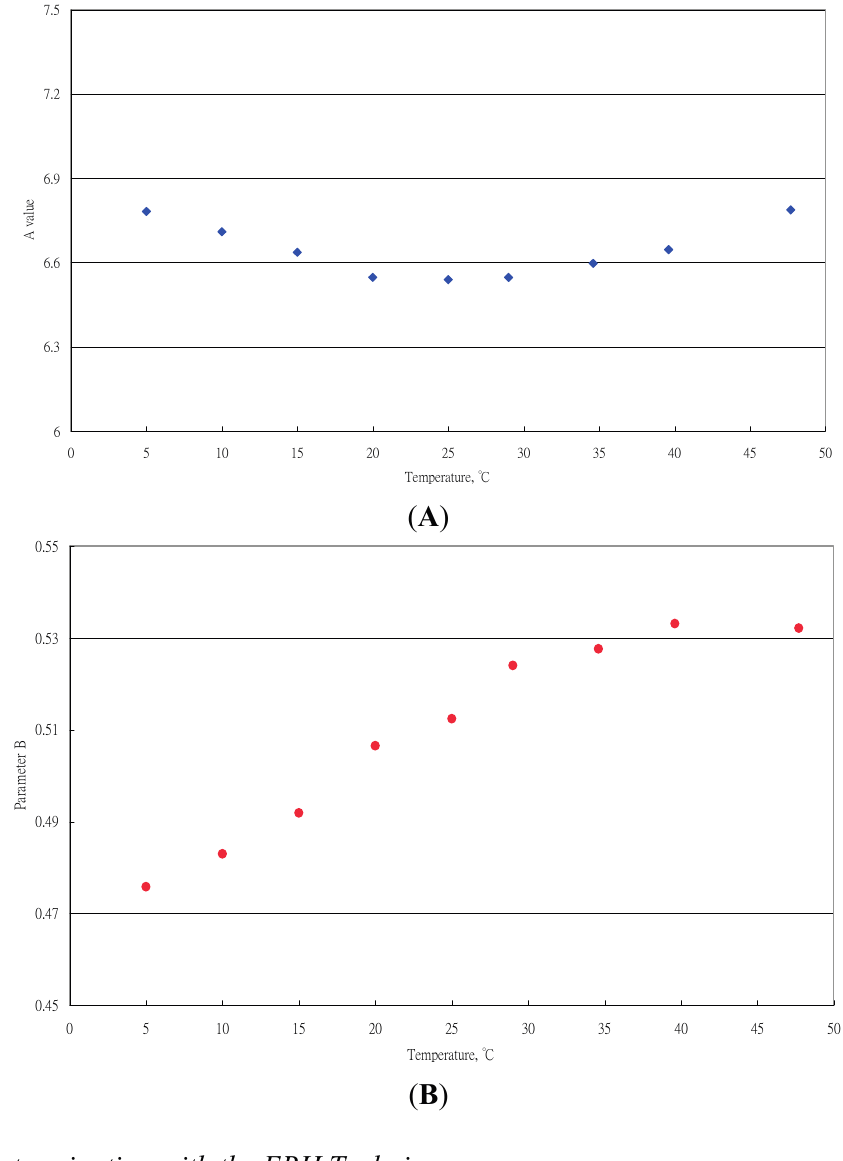
Figure 3. Effect of temperature on parameters A and B of the Oswin